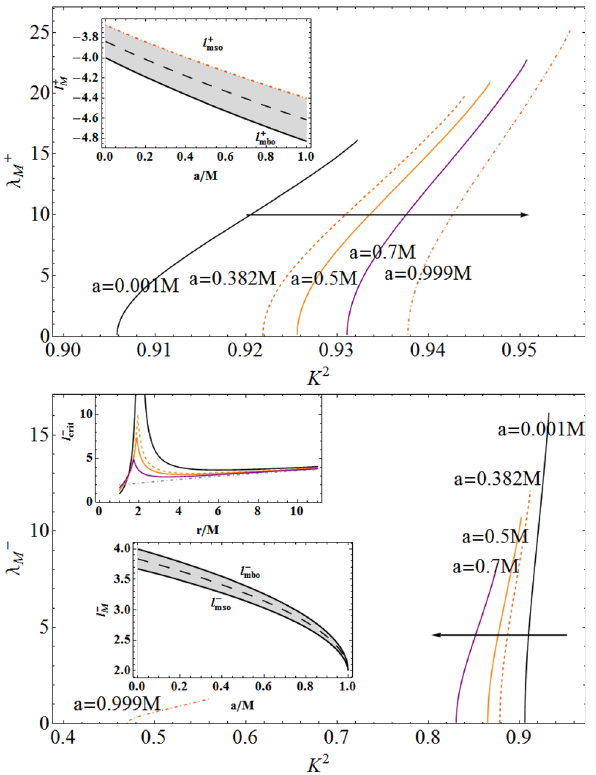
Fig. 9 Torus elongation λ M ( a ; (cid:4) M , K 2 ) in Eq. (13) on the equatorial plane for corotating λ − ( leftpanel ) and counterrotatingfluids λ + ( right M M panel ) for fixed values of SMBH spin a / M (as singed on each curves) as function of K 2 , where K ∈ [ K mso , 1 [ . Arrows follow increasing ≡ ± ((cid:4) ∓ − (cid:4) ∓ )/ 2, dashed values of SMBHs a / M . There is (cid:4) ∓ mso M mbo black curve in inside panels, gray region sets the the entire range of variation of tori specific fluid angular momentum (cid:4) depending on the central SMBH dimensionless spin a / M , and the range for the function (cid:4) (cid:4) − as function of a / crit . Right inside panel shows the curves crit